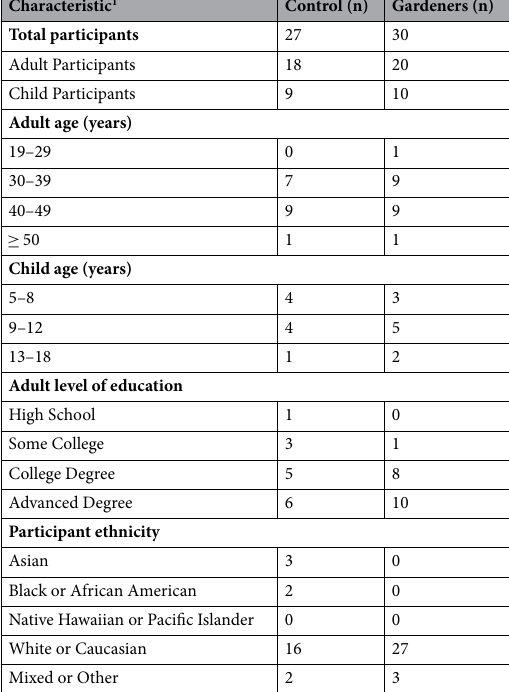
Table 1. Participant demographics. 1 All characteristics reported as